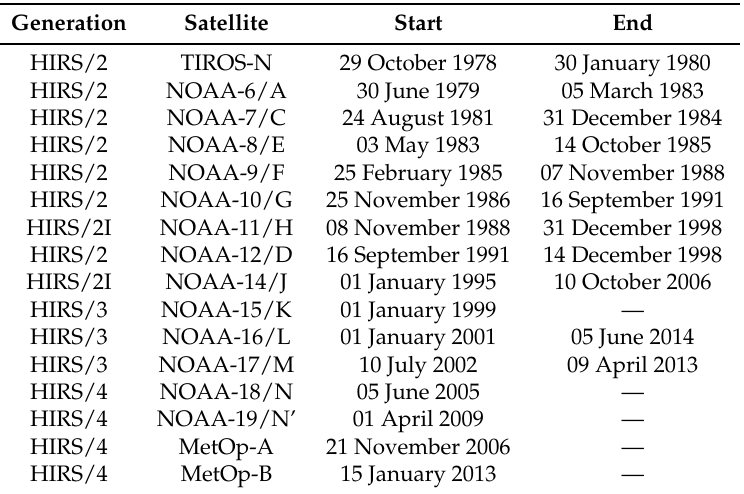
Table 1. HIRS versions considered in this